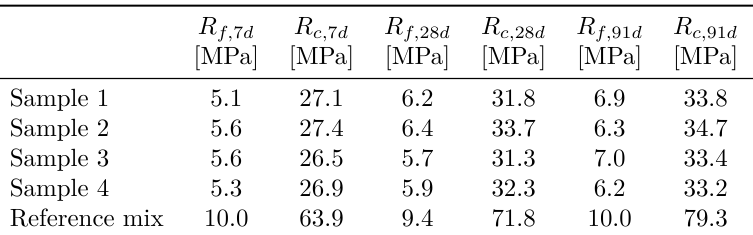
Table 2. Mechanical properties of the mortar mixtures with treated fines.